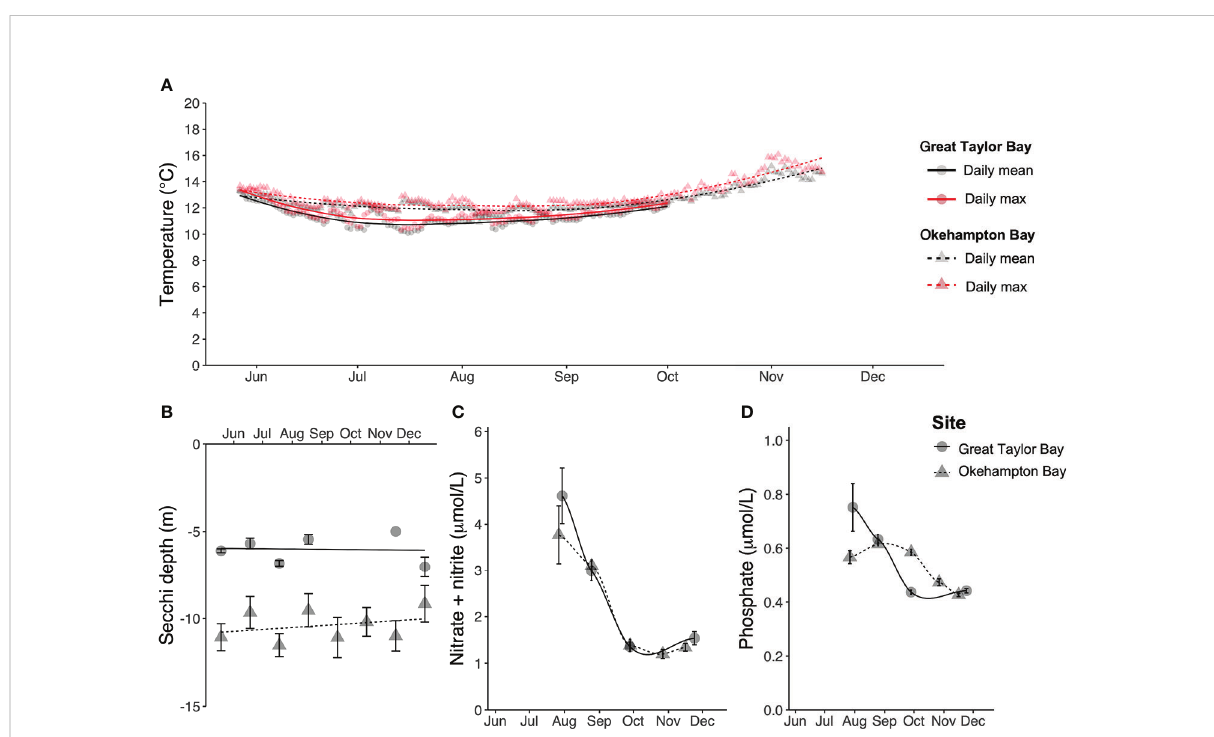
FIGURE 2 Environmental conditions at both farm sites in Tasmania (A) Daily mean and maximum temperature (°C), (B) Secchi depth (m), (C) dissolved nitrate + nitrite (µmol L -1 ), and (D) dissolved phosphate (µmol L -1 ). Error bars show SEM, with N = 1 – 18 for Secchi depth, and N = 6 for nitrate + nitrite and phosphate. For temperature, N = 2 for each site, but SEM (ranging 9.7 – 16.1°C) bars ommitted for visual